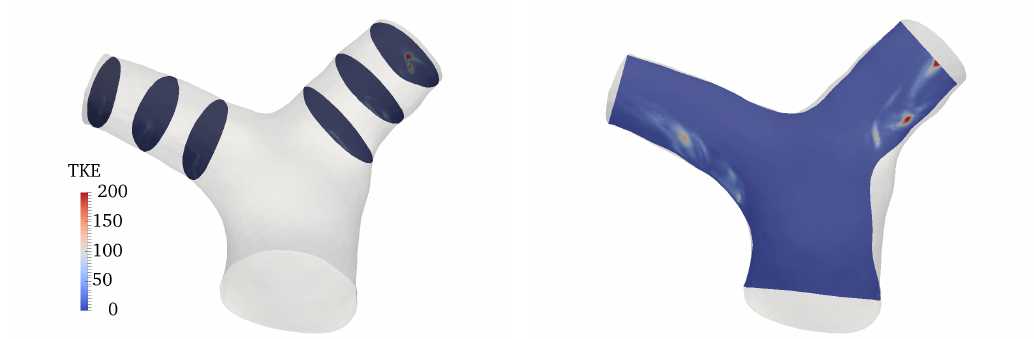
Figure 9. Contour of turbulent kinetic energy at the deceleration phase along several slices of the computational